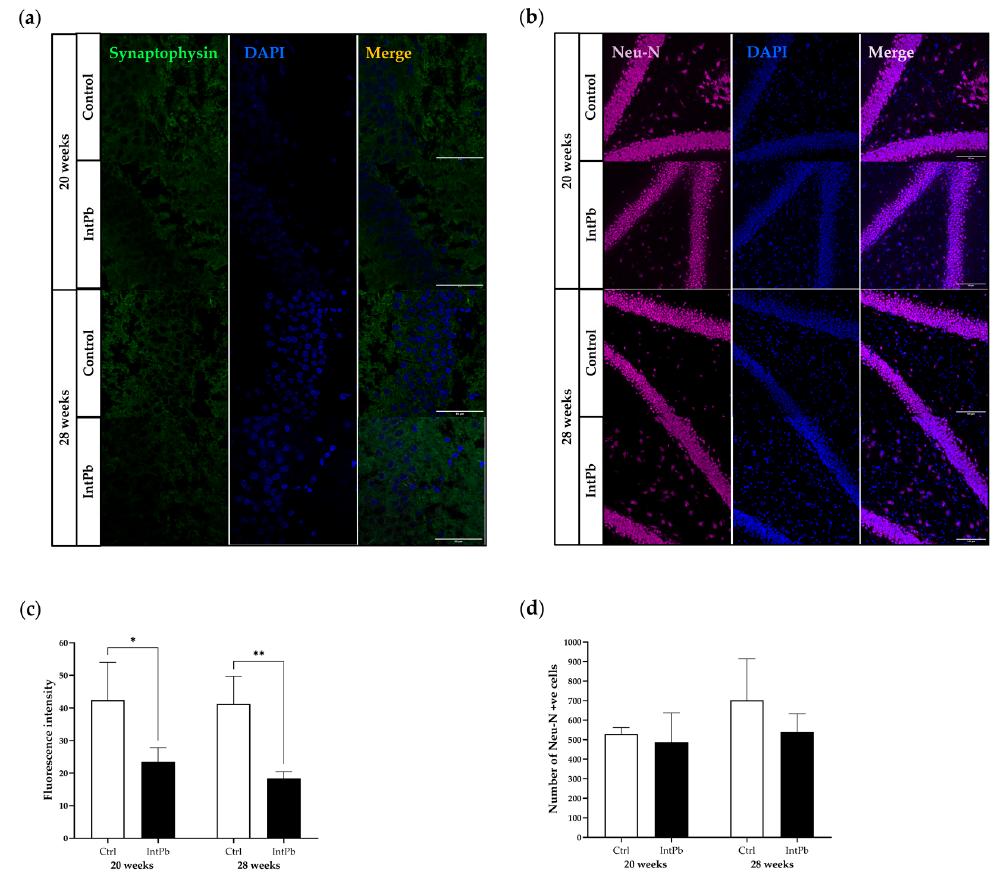
Figure 6. Synaptic alterations (Syn) and neurodegeneration (NeuN) results evaluated by the im ‐ munohistochemistry technique. ( a ) Representative images of the Syn (1:500) ‐ stained pre ‐ synapses. ( b ) Histogram of the fluorescence intensity of Syn staining. ( c ) Representative images of the NeuN (1:500) ‐ stained neurons. ( d ) Histogram of NeuN ‐ positive cells’ quantification. Images were acquired using a confocal point scanning microscope (Zeiss LSM 880 with Airyscan) with 20 × objective. Scale bar is 50 μ m for stained images. Values are expressed as the mean ± SD for n IntPb = 3–4 and n Ctrl = 3–4 for each evaluated time ‐ point. The symbols denote statistically significant differences inter groups (Ctrl vs. IntPb—* p < 0.05, ** p < 0.01); two ‐ way ANOVA, Tuckey’s multiple comparison test.